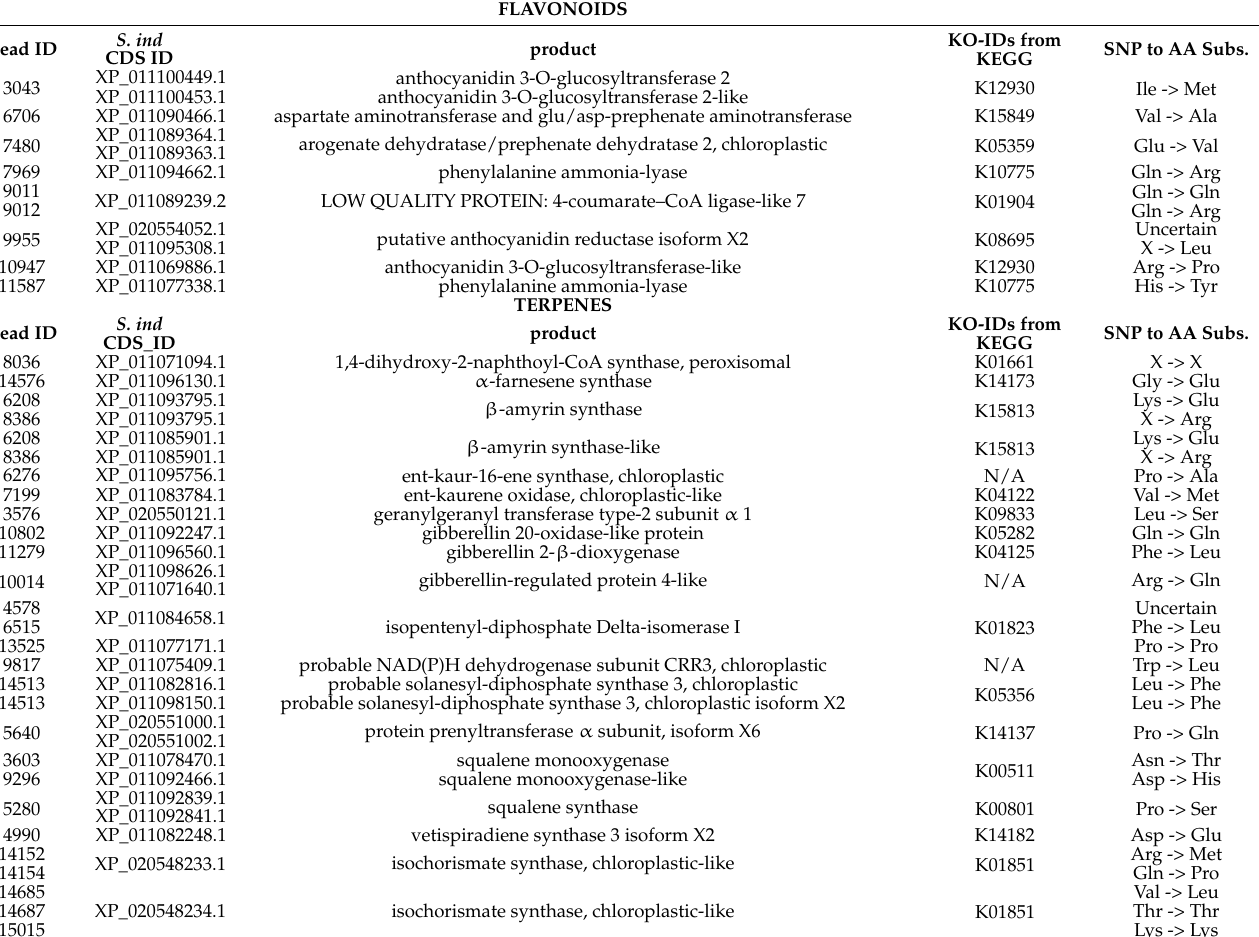
Table 7. Multiple alignments results reporting read ID, S. indicum (GCF_000512975.1) accession number on NCBI database, Flavonoid/Terpenes product, KEGG ID, amino acid substitution based on the polymorphic SNP in the 15 individuals of Lavandula